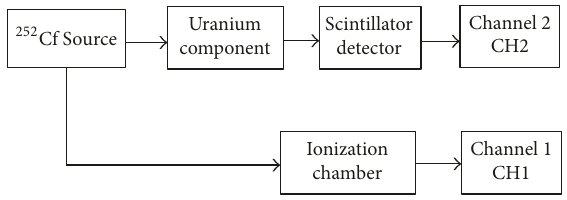
Figure 1: Flowchart of the proposed identification system.